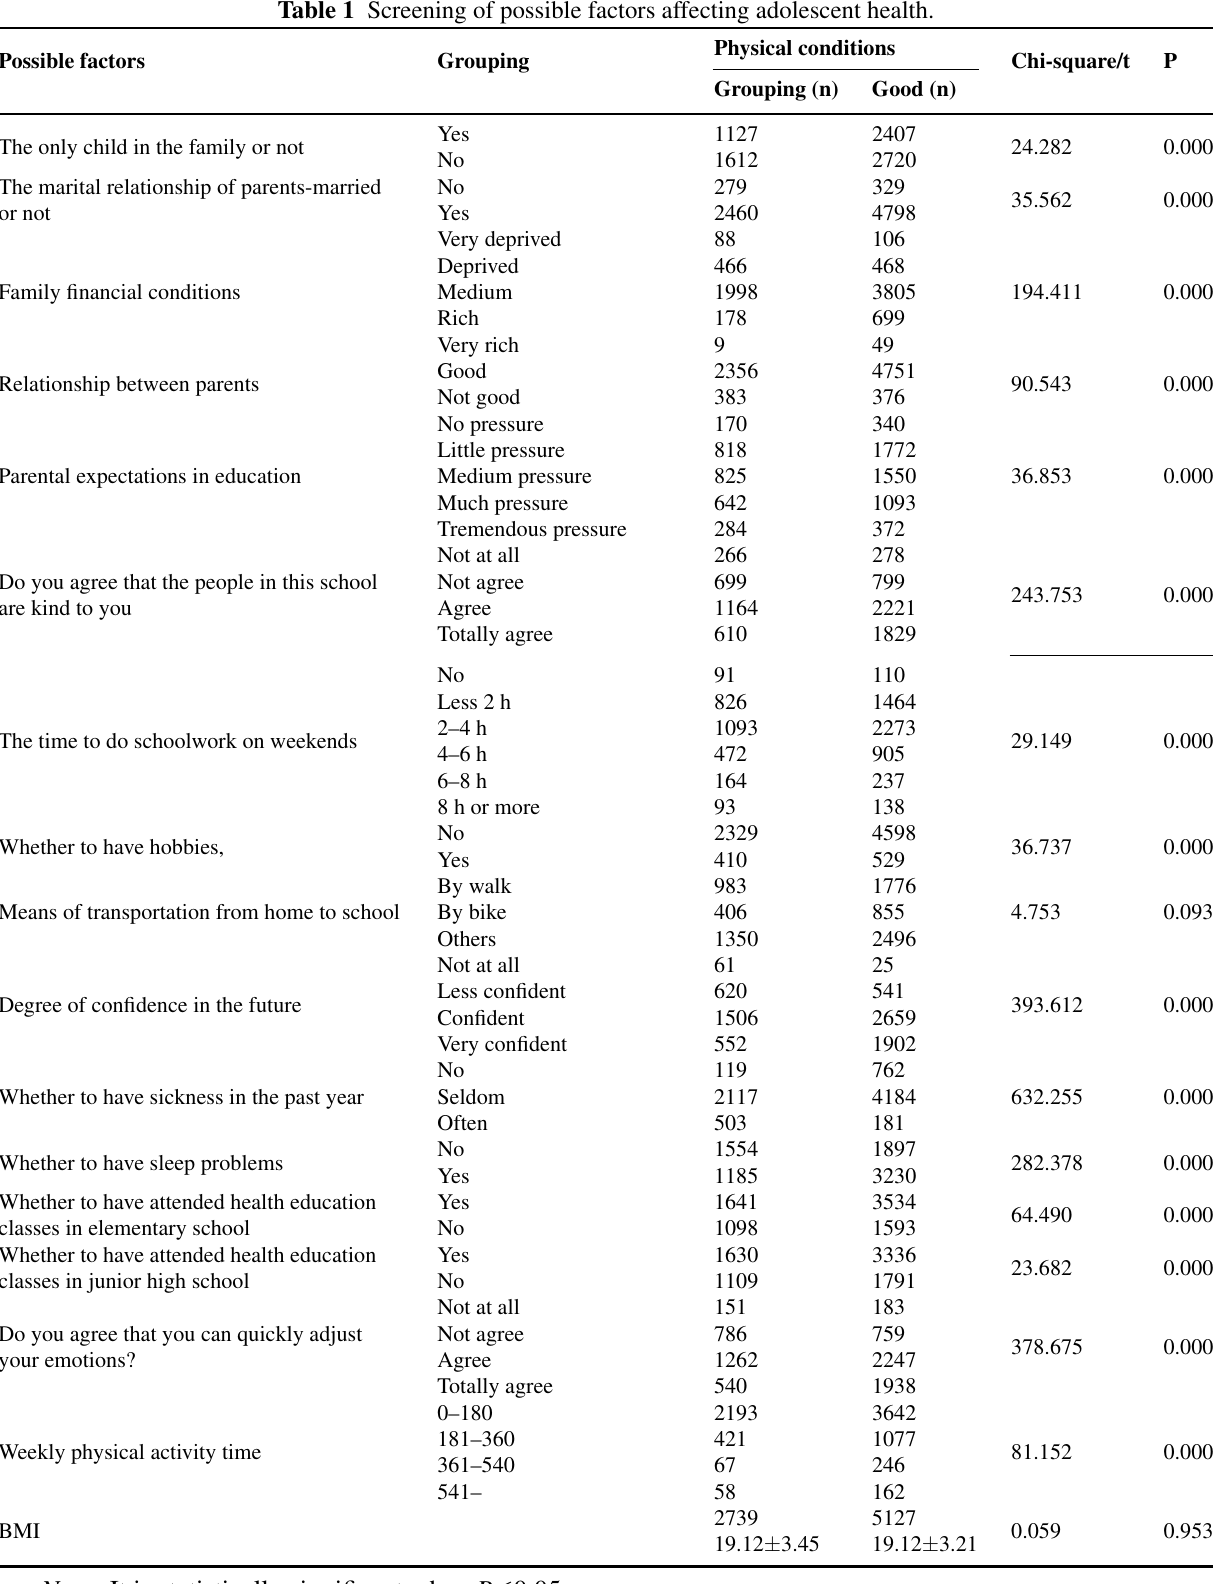
Table 1 Screening of possible factors affecting adolescent